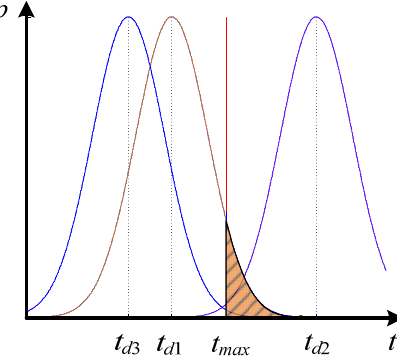
Figure 6. The probability density function of the consistent delay.